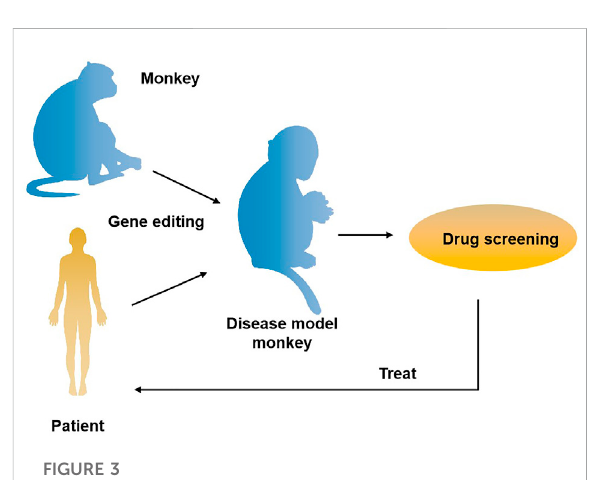
FIGURE 3 The application of gene-edited monkey models in drug development and treatment for the disease. A transgenic monkey model constructed by gene editing can be applied to drug screening for human diseases such as neurodegenerative diseases and cancer, thus providing an opportunity for disease